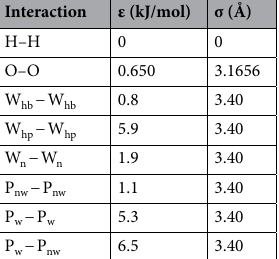
Table 1. LJ interaction parameters for different